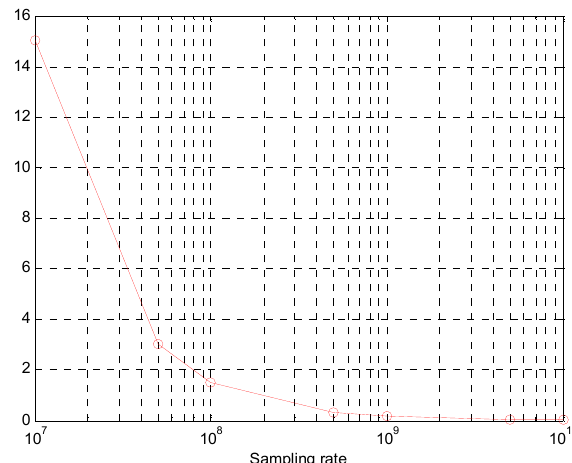
Figure 6. Mean square error (MSE) of distances between MS and base stations (BSs) for the first case.